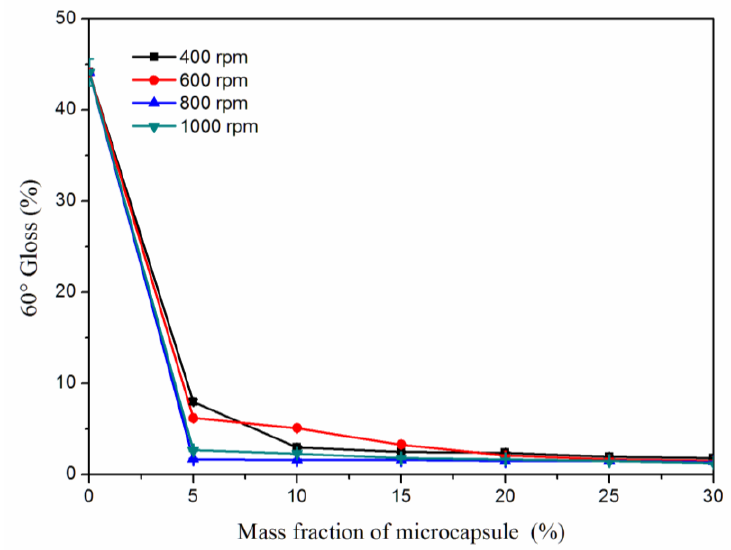
Figure 9. E ff ect of the mass fractions of microcapsules with di ff erent stirring rates on the gloss of Figure 9. Effect of the mass fractions of microcapsules with different stirring rates on the gloss of water-based paint water-based paint film.